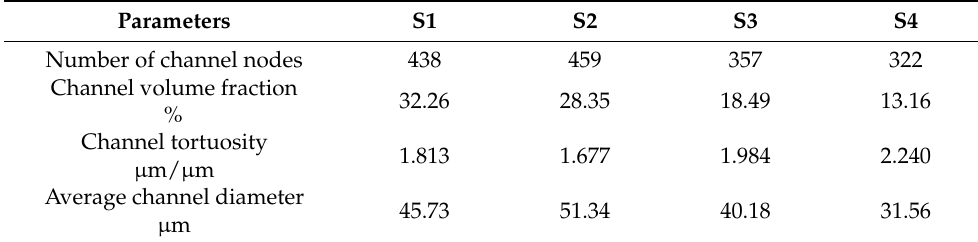
Table 4. Statistical table of seepage channel.